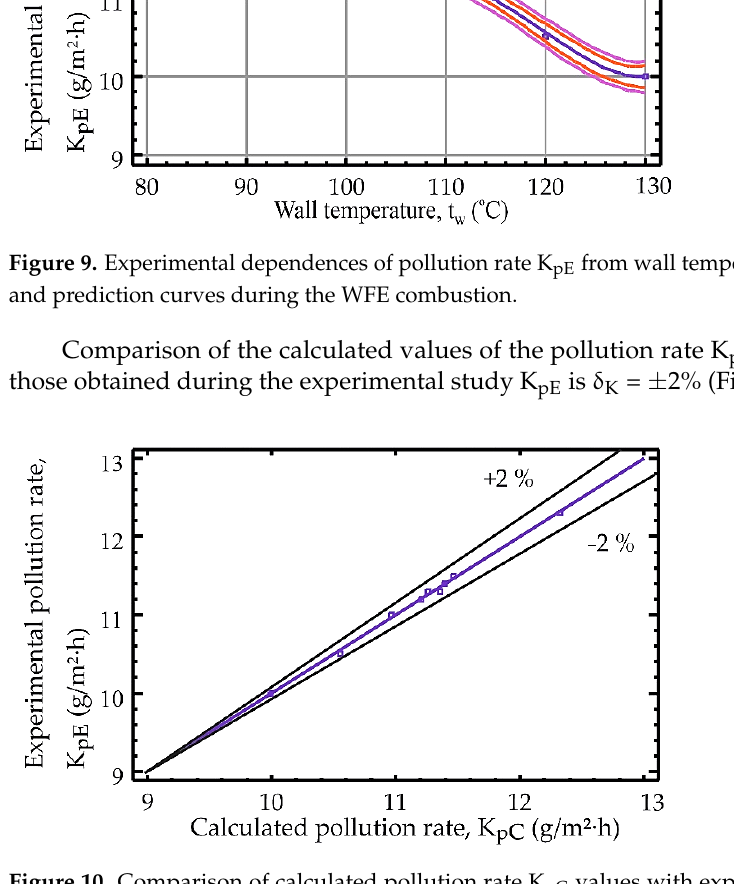
Figure 11. Dependences of pollution rate K p on wall temperature t w during the fuel oils and WFE combustion.